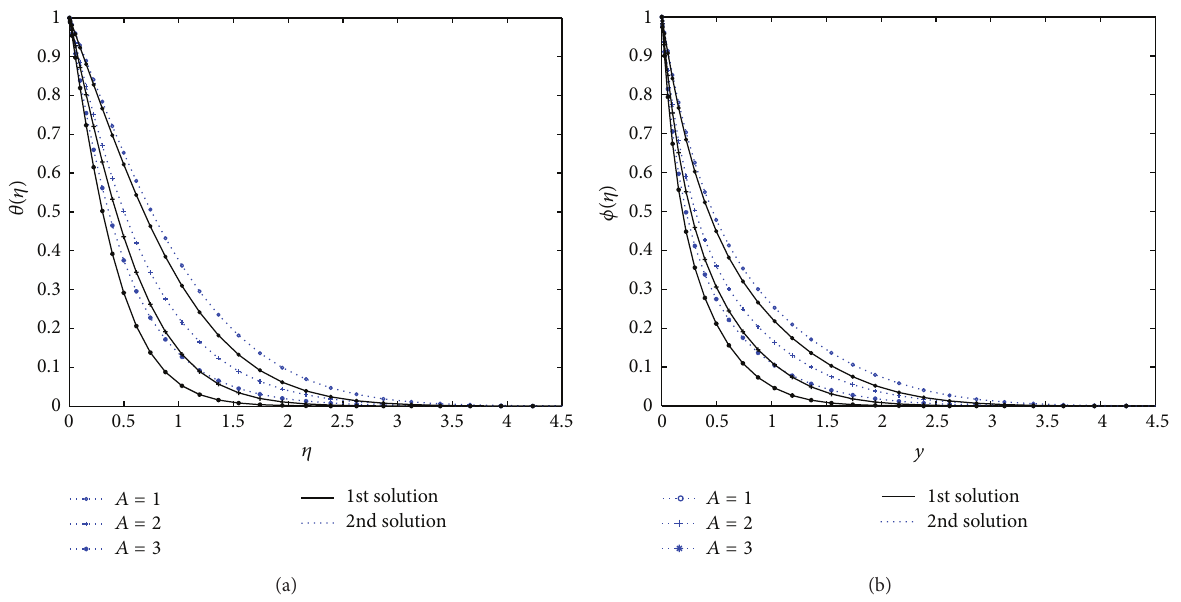
Figure 6: Multiple solutions of (a) temperature profiles 𝜃(𝜂) and (b) nanoparticle volume fraction for various values of 𝐴 when 𝜆 = −0.1 , 𝑠 = 1 .